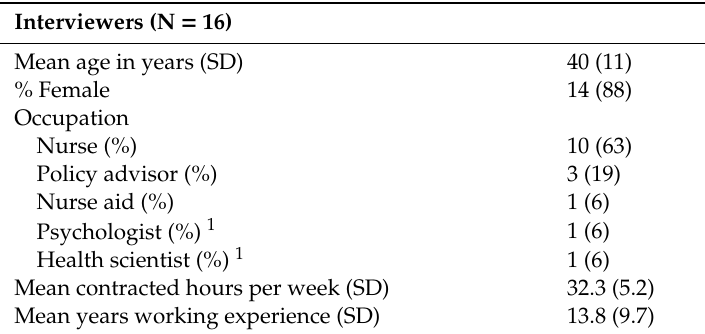
Table 3. Interviewer demographics and data